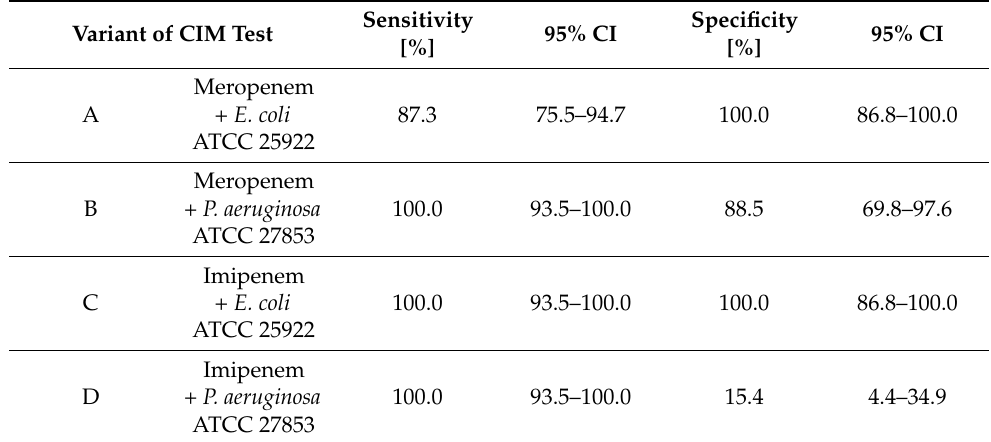
Table 3. Diagnostic value of CIM test variants for non-fermenting rods ( n =